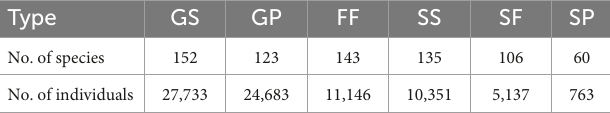
TABLE 1 Number of species and individuals in each vegetation transition type (see main text for definition of each